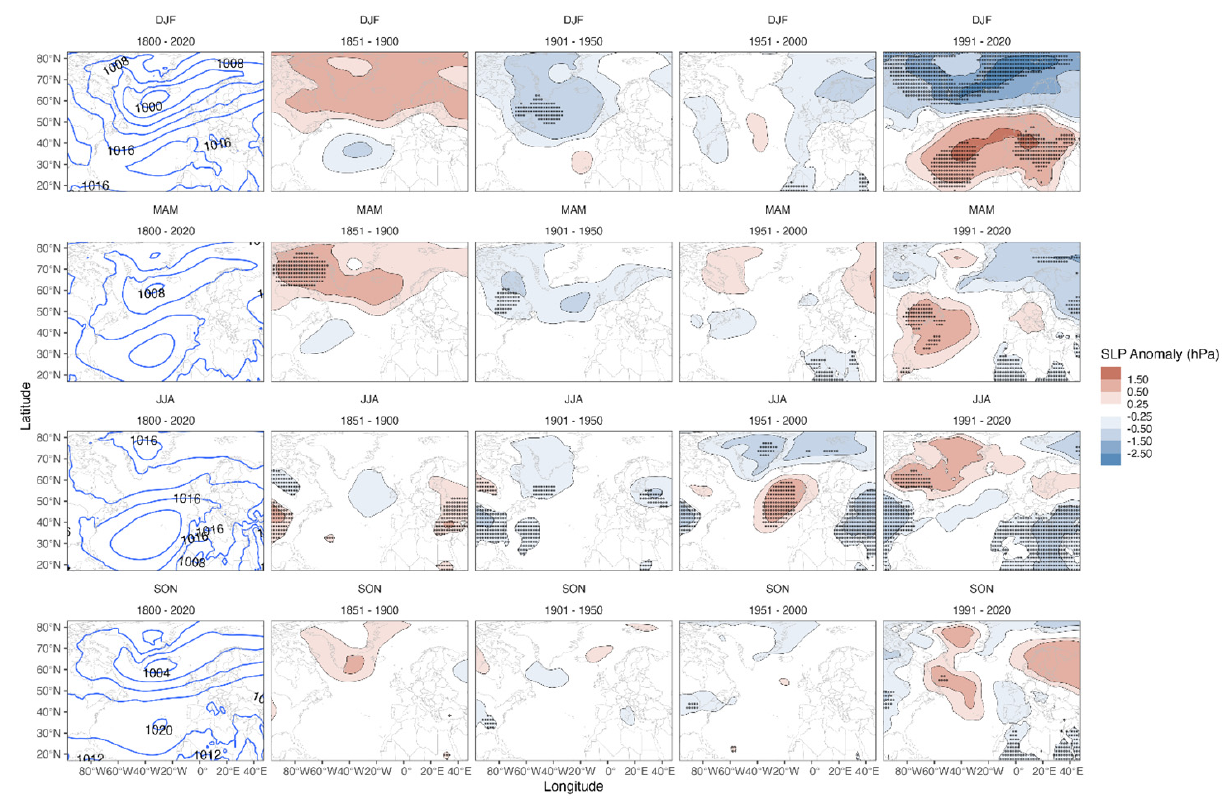
Figure 2. Seasonal mean conditions for 1800–2020 ( left column ) and anomalies for various periods (with respect to 1800–2020) of the spatial pattern of North Atlantic mean sea-level pressure based on our spliced EKF400v2–ERA5 series for ( top to bottom ) winter (DJF), spring (MAM), summer (JJA) and autumn (SON). The stippling shows areas of significant ( p ≤ 0.05) anomalies where the mean sea-level pressure anomaly is ≥ ±0.25 hPa.